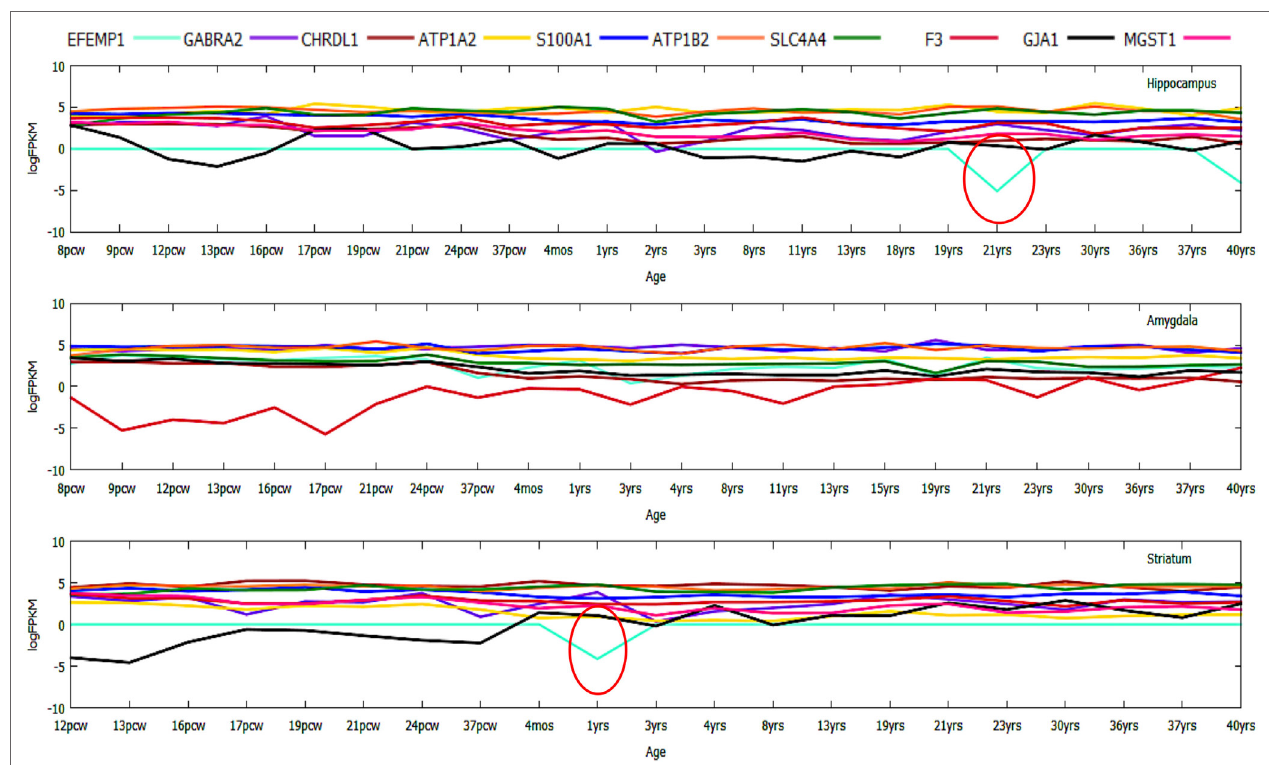
FigUre 7 | Gene expression profiling of top 10 downregulated genes during prenatal to postnatal brain developmental stages displaying numerous inconsistently or dynamically expressed genes like DOCK2